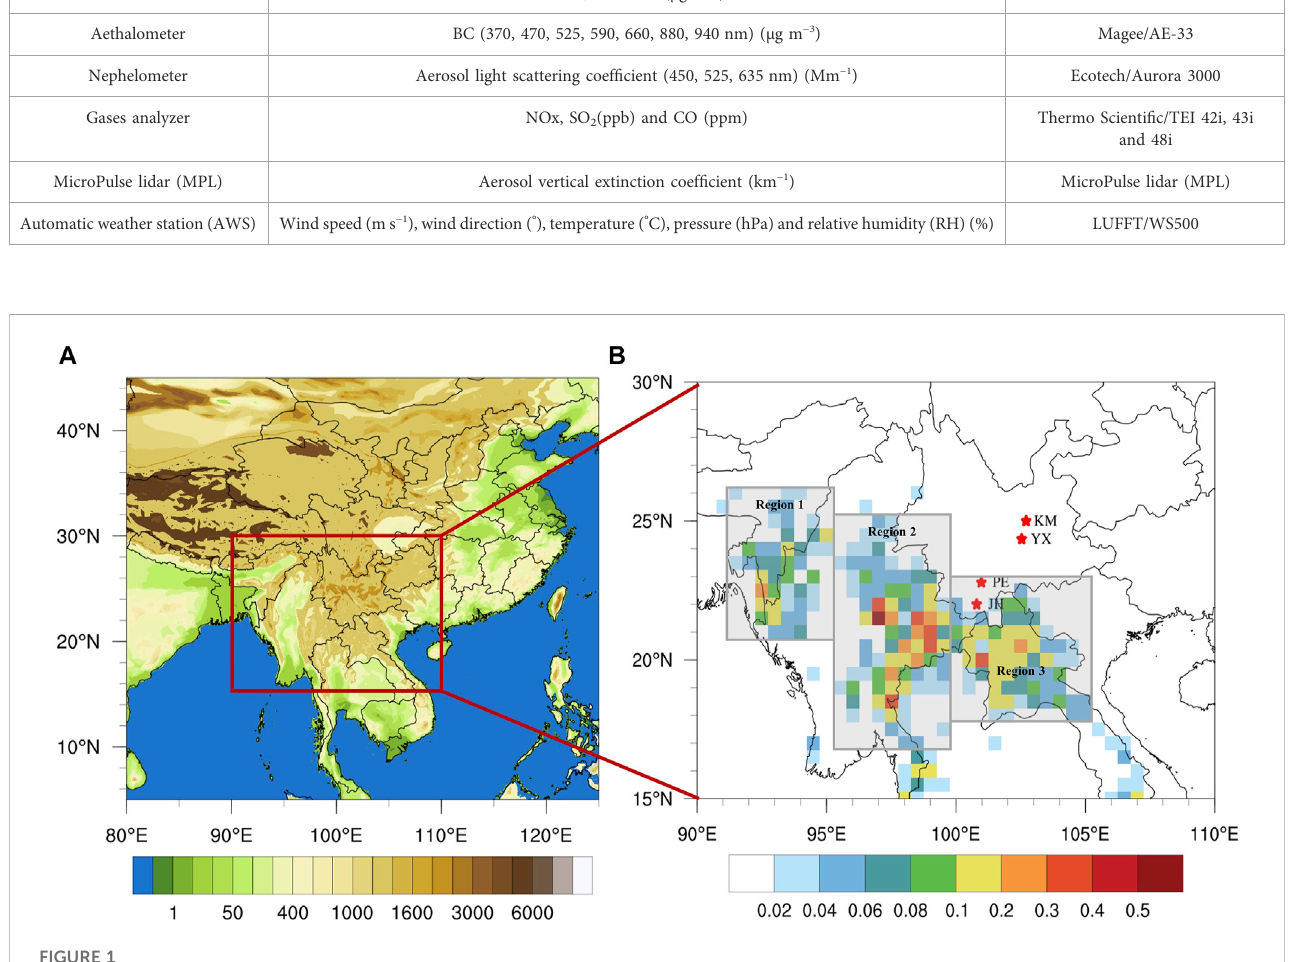
FIGURE 1 The study domain with terrain height (unit: meter) and thefocused area (A) . The spatial distributionof mean emission rates (mg m − 2 hr − 1 )of black carbon (BC) from GFED during the study period and thethree sub-regions where biomass burning occurred (B) . Red stars denote themajor sites where observations for meteorology, air pollutants concentrations are available for model validation (JH, Jinghong, 100.80 ° E, 22.01 ° N; PE, Puer, 100.98 ° E, 22.80 ° N; YX, Yuxi, 102.54 ° E, 24.36 ° N; KM, Kunming, 102.71 ° E, 25.01 °